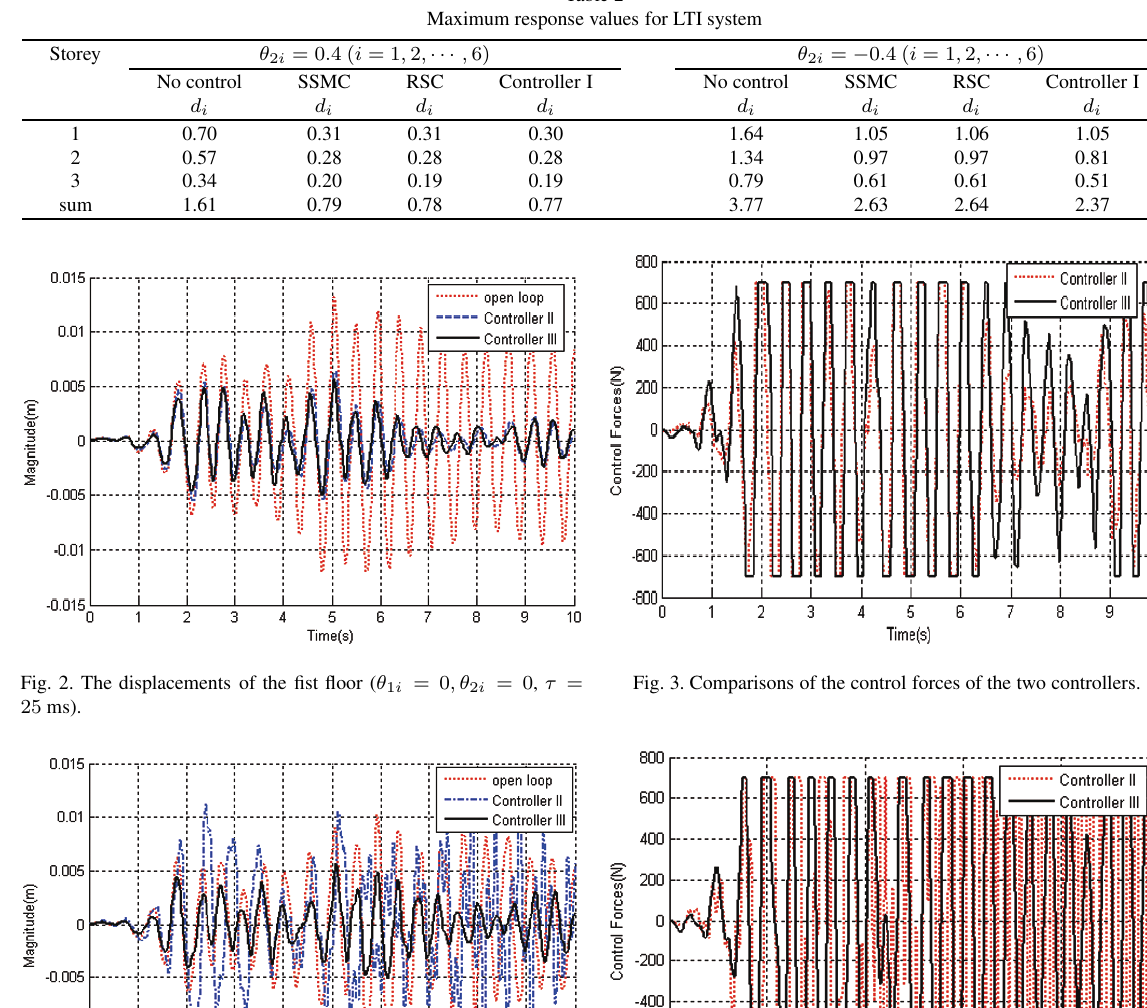
Fig. 5. Comparisons of the control forces of the two